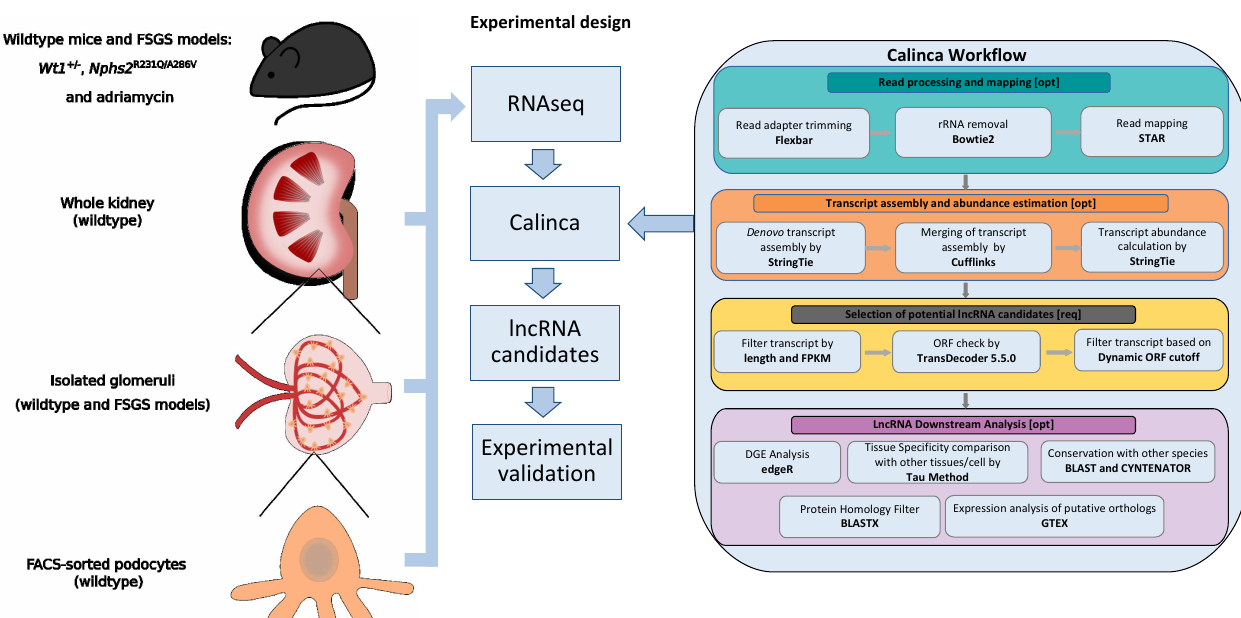
Figure 1. The CALINCA pipeline. Experimental design and stepwise visualization of the CALINCA pipeline developed for this study. RNA-seq data generated from podocytes, glomeruli, and whole kidneys of wildtype mice alongside glomeruli from three focal-segmental glomerulosclerosis (FSGS) models (Wt1 +/ − , Nphs2 R231Q/A286V , Adriamycin) were analyzed according to the depicted CALINCA workflow. For a more detailed overview of the datasets, see “CALINCA Flowchart” on https://calinca.dieterichlab.org. Briefly, long non-coding RNA (lncRNA) expression in renal compartments is quantified after read processing and mapping. In addition, the quantification of annotated lncRNAs novel transcripts is detected using a reference-guided de novo assembly. The lncRNA candidates were defined based on open reading fram (ORF) cutoffs. These candidates are then checked for tissue-specificity using the tissue specificity index (TSI) method and evolutionary conservation based on synteny and sequence.